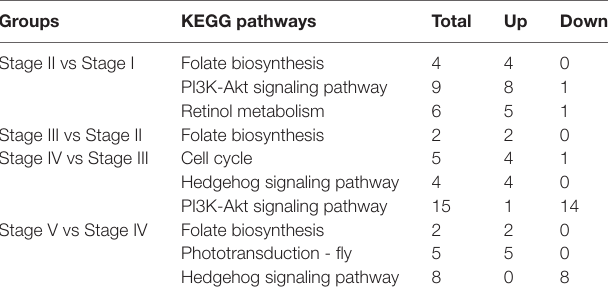
TABLE 1 | The enriched KEGG pathways related to ovarian development of E. carinicauda.